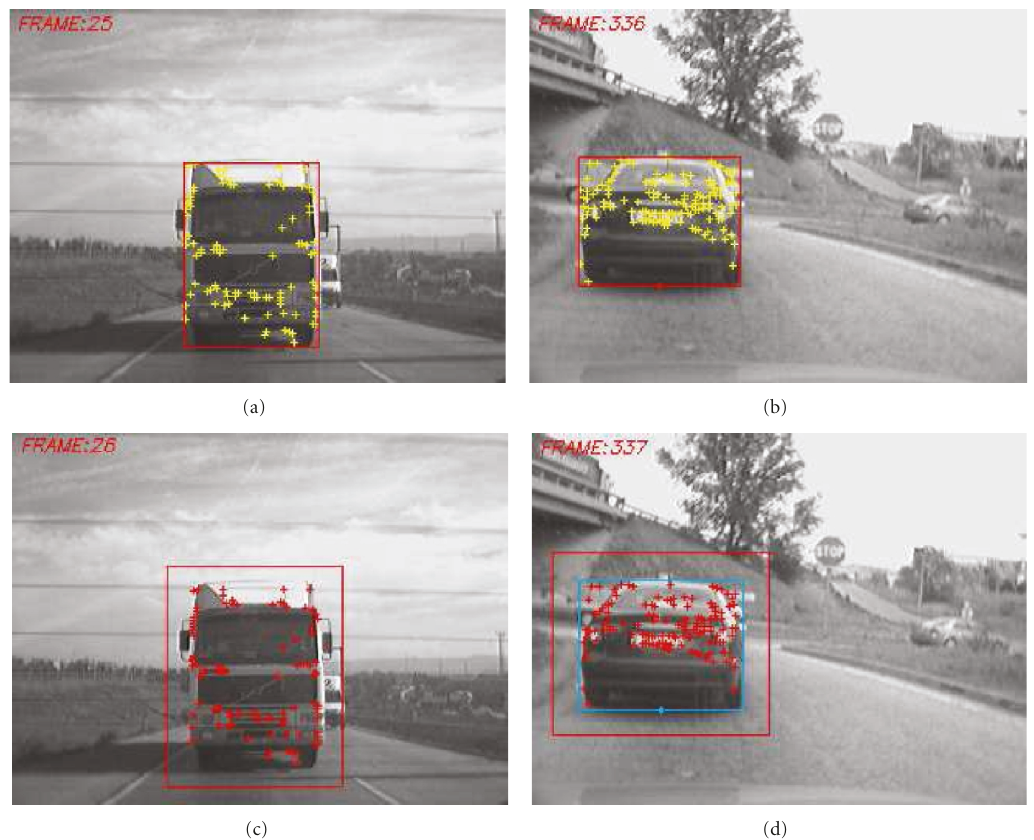
Figure 15: Data association by features matching. (a, b) Harris features on image t . (c, d) matched Harris features on image t + 1.